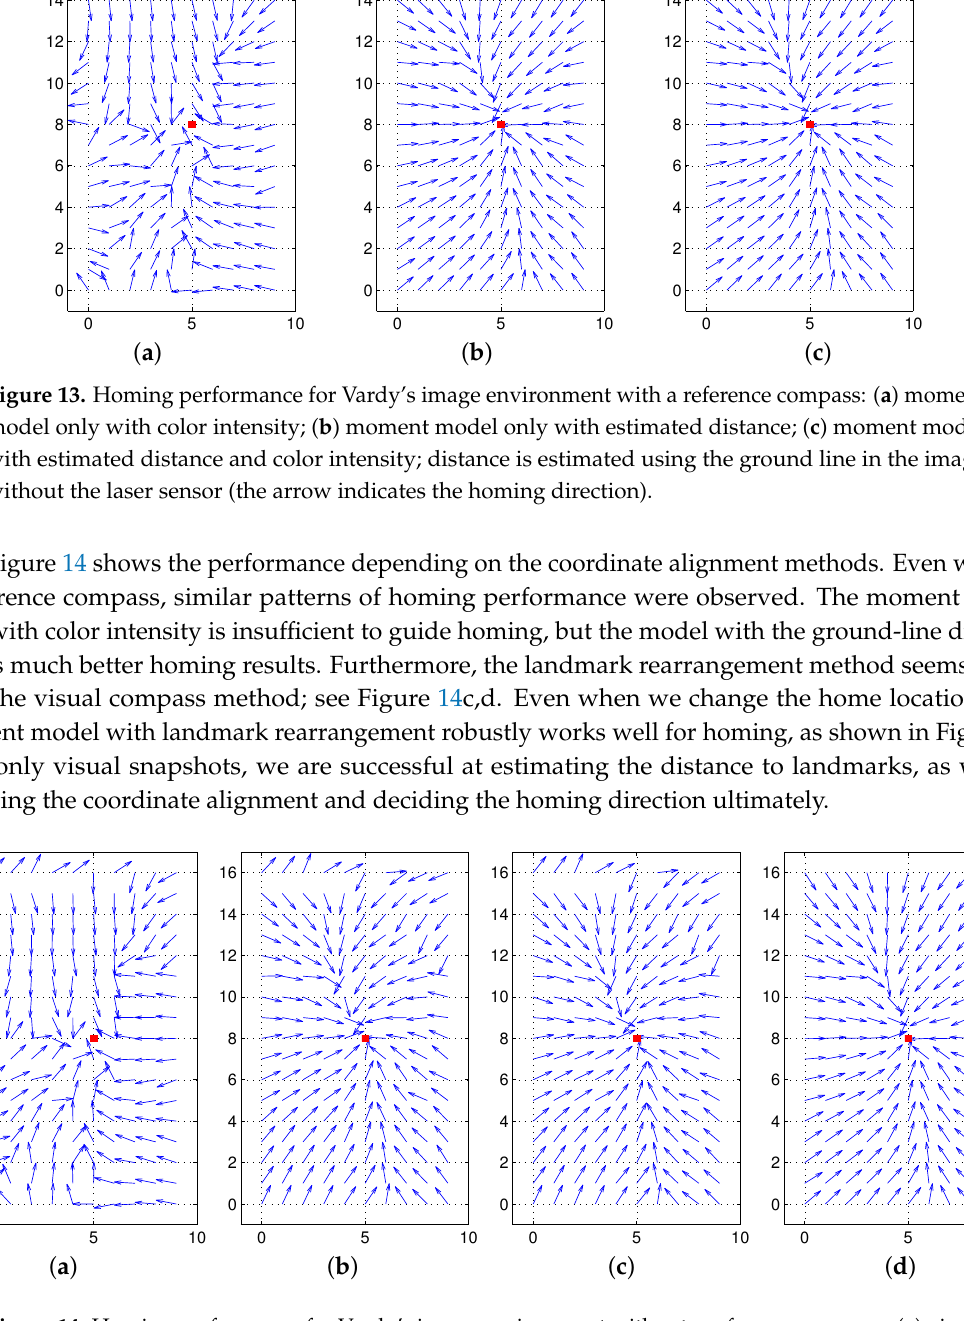
Figure 14. Homing performance for Vardy’s image environment without a reference compass: ( a ) visual compass and moment model only with color intensity; ( b ) visual compass and moment model only with estimated distance; ( c ) visual compass and moment model with both estimated distance and color intensity; ( d ) landmark rearrangement method and moment model with both estimated distance and color intensity; distance is estimated using the ground line in the image without a laser sensor (arrow indicates the homing